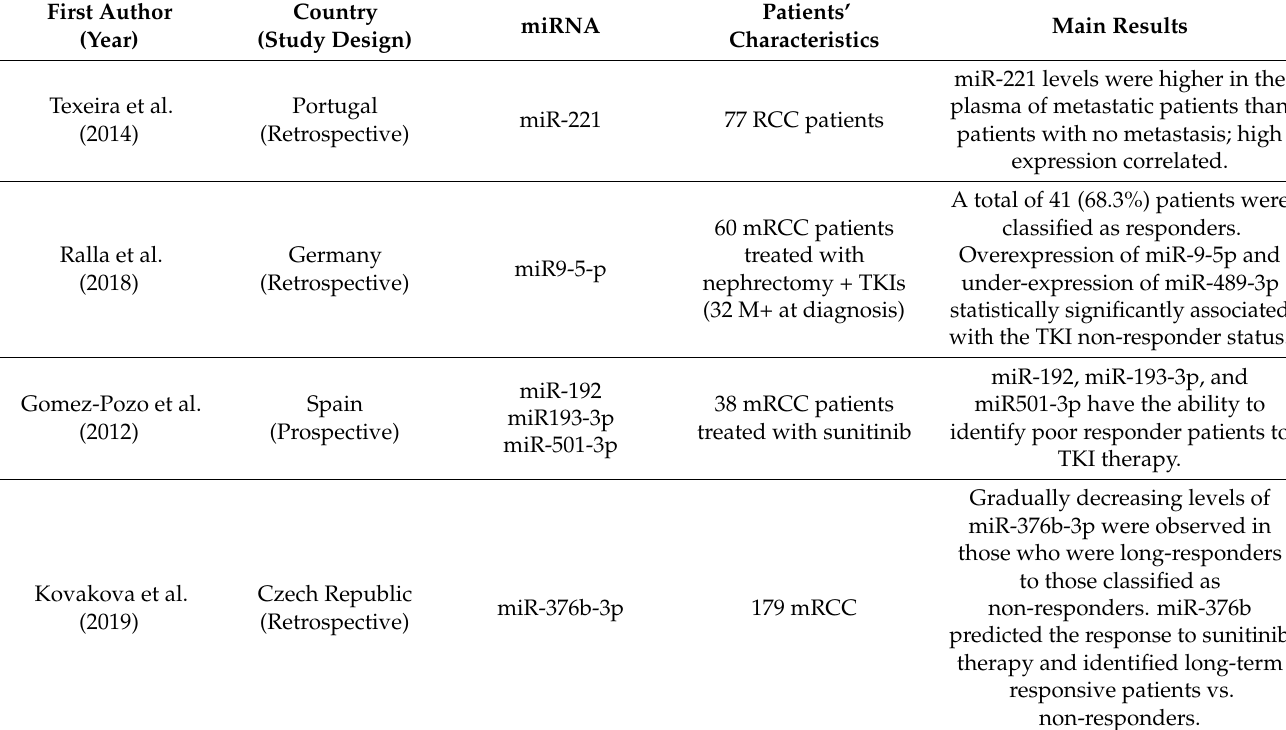
Table 1. The main characteristics of studies investigating the effects of plasmatic miRNAs in patients diagnosed with renal cell